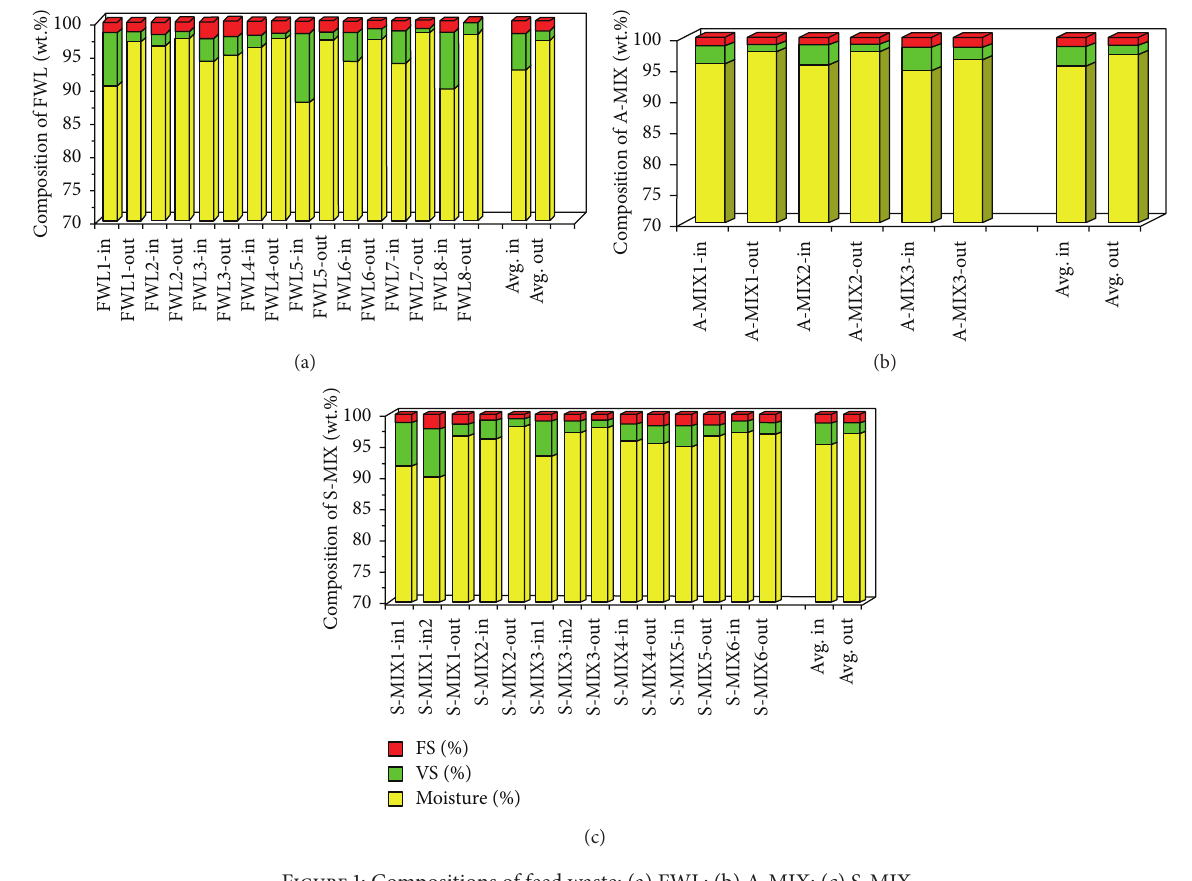
Figure 1: Compositions of feed waste: (a) FWL; (b) A-MIX; (c) S-MIX.